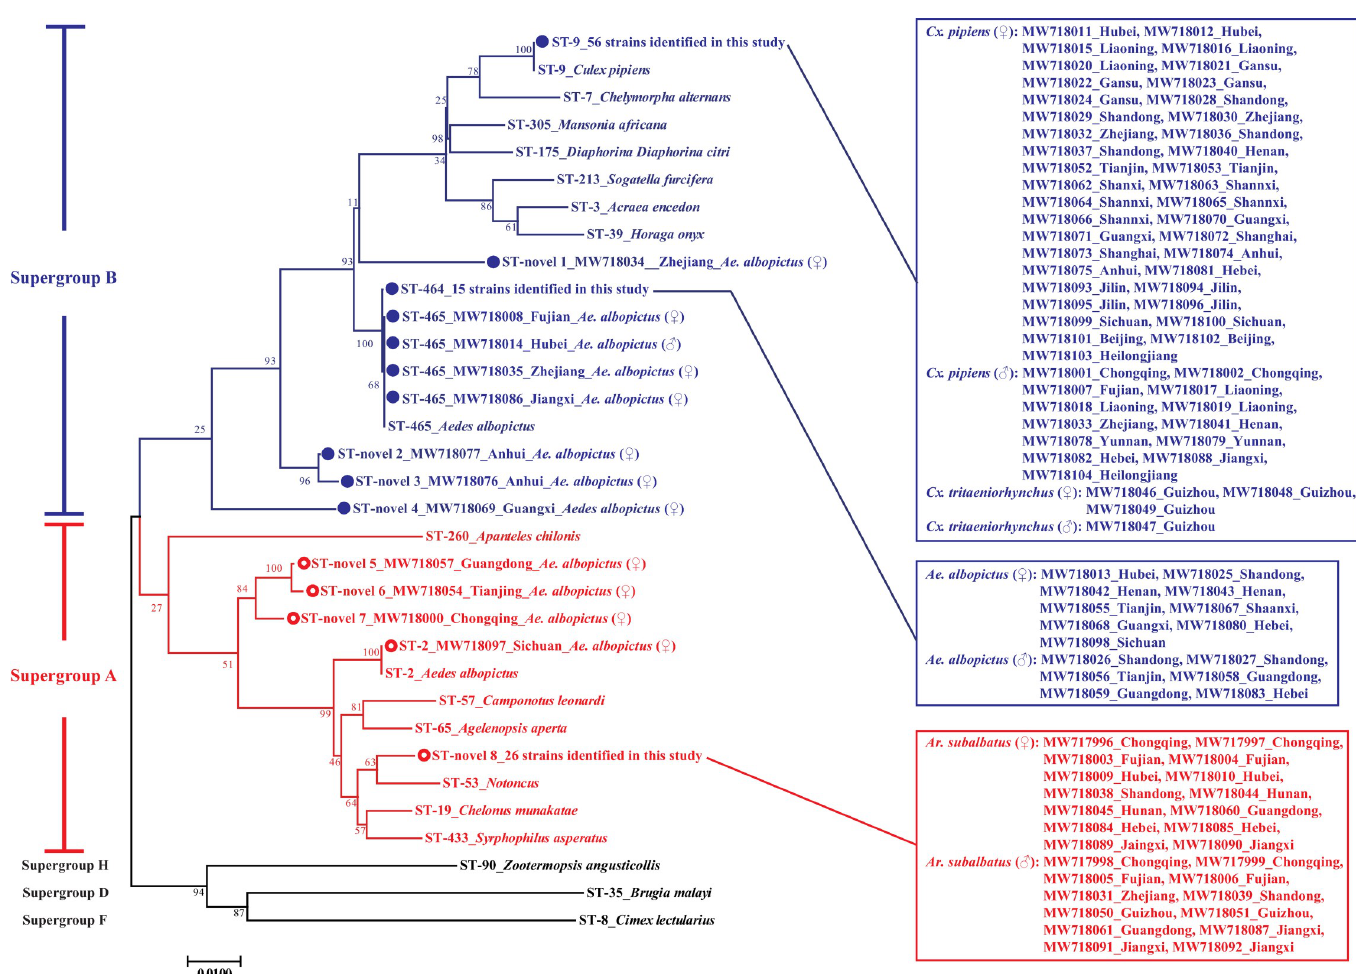
Fig 3. Neighbor-joining phylogenetic tree based on five MLST loci ( gatB , coxA , hcpA , ftsZ and fbpA ) of the strains obtained in this study and GenBank database. Strains identified in this study are identified with open circles ( � ) for supergroup A (in red) and filled circles (•) for supergroup B (in blue). The GenBank accession number of wsp sequences of each strain identified in this study was marked on the right side of ST code. The numbers at the branches show bootstrap support (1000 replicates). The bar at the bottom of the figure denotes